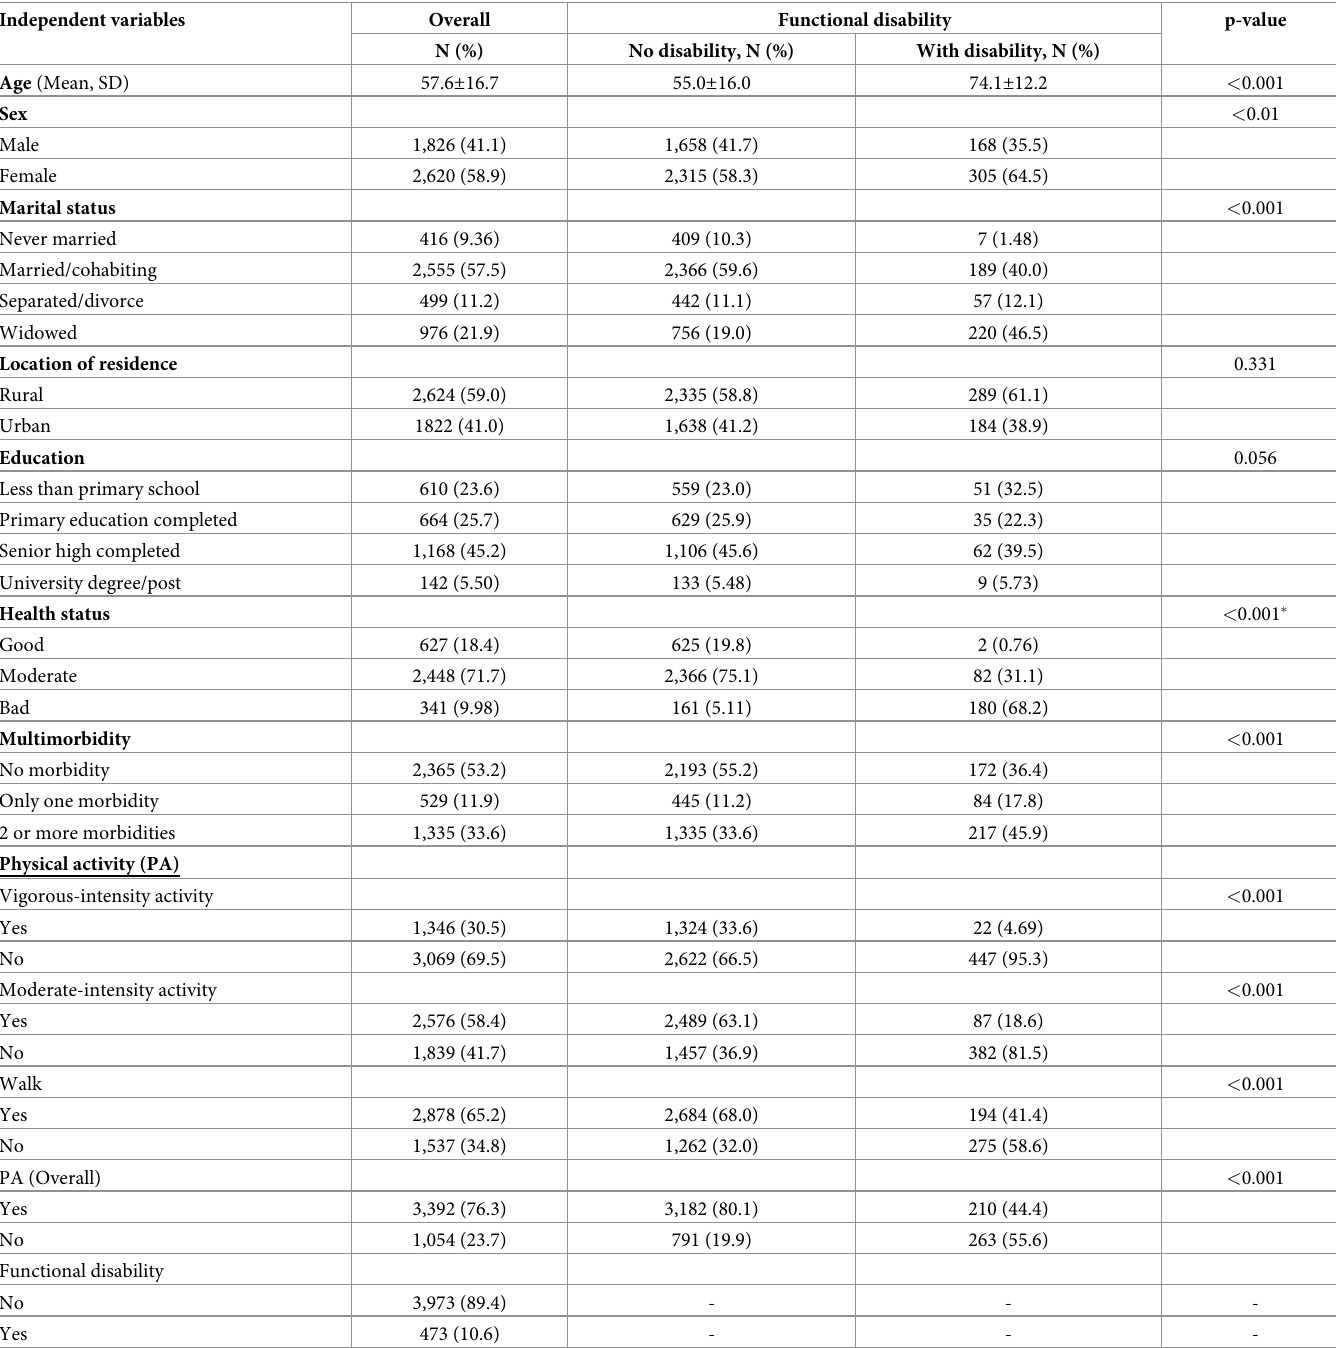
Table 1. Univariate and bivariate analysis of independent variables and functional disability. Independent